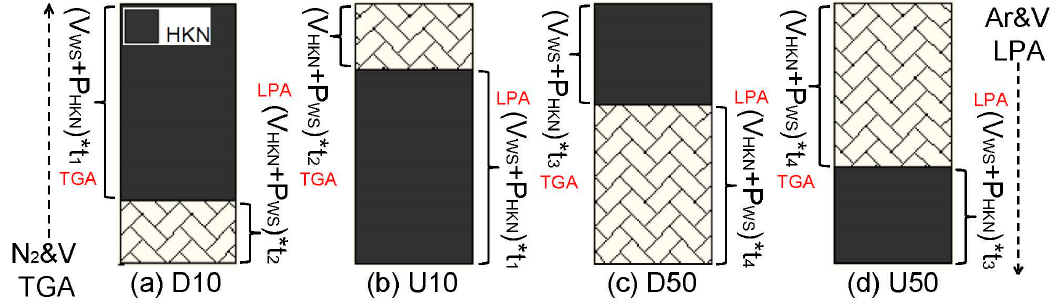
Figure 4. Mechanism for synergy effect occurred in TGA and LPA reactor under different contact conditions, ( a ) D10, ( b ) U10, ( c ) D50, ( d ) U50.